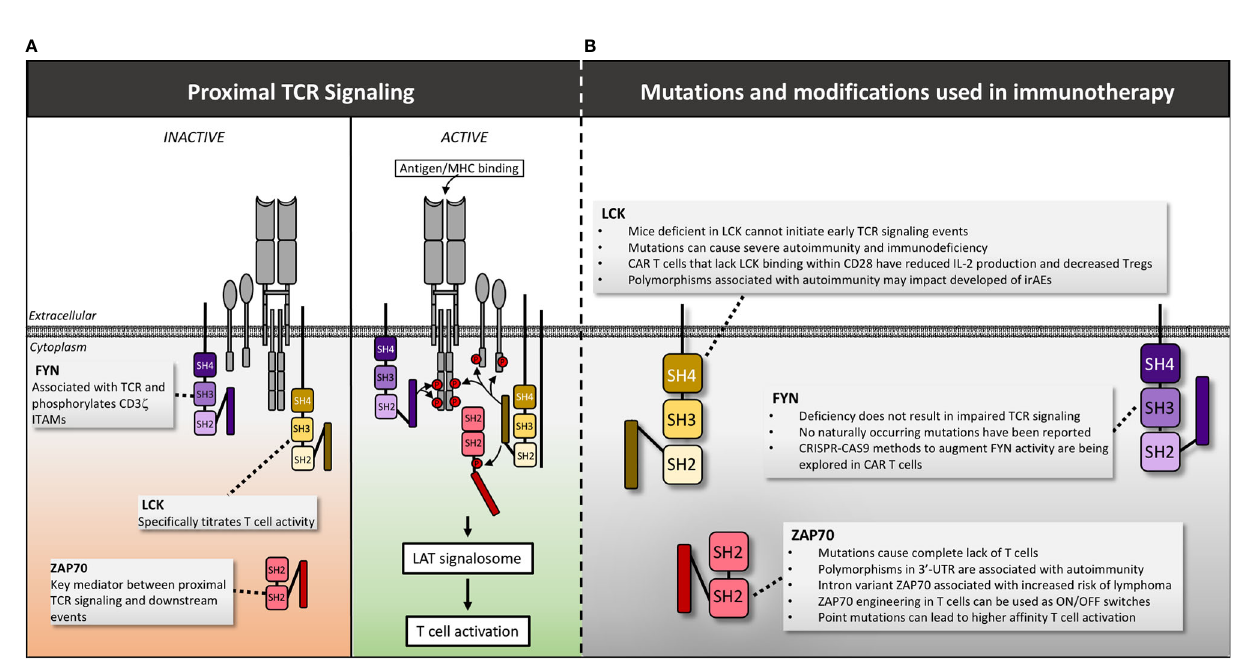
FIGURE 4 | LCK, FYN and Zap70 structure, mutations and manipulations for immunotherapy. (A) Following antigen/MHC binding, LCK is recruited fi rst to the TCR, initiating phosphorylation of ITAMs within the CD3 intracellular domains. Subsequently FYN is recruited and assists in phosphorylation of CD3 z ITAMs. LCK then phosphorylates the linker sequence of ZAP70 causing a conformational change that actives the kinase activity of ZAP70 permitting additional downstream signaling. (B) The impact of mutations and genetic manipulation of LCK, FYN and ZAP70 are detailed. Red circles denote phosphate